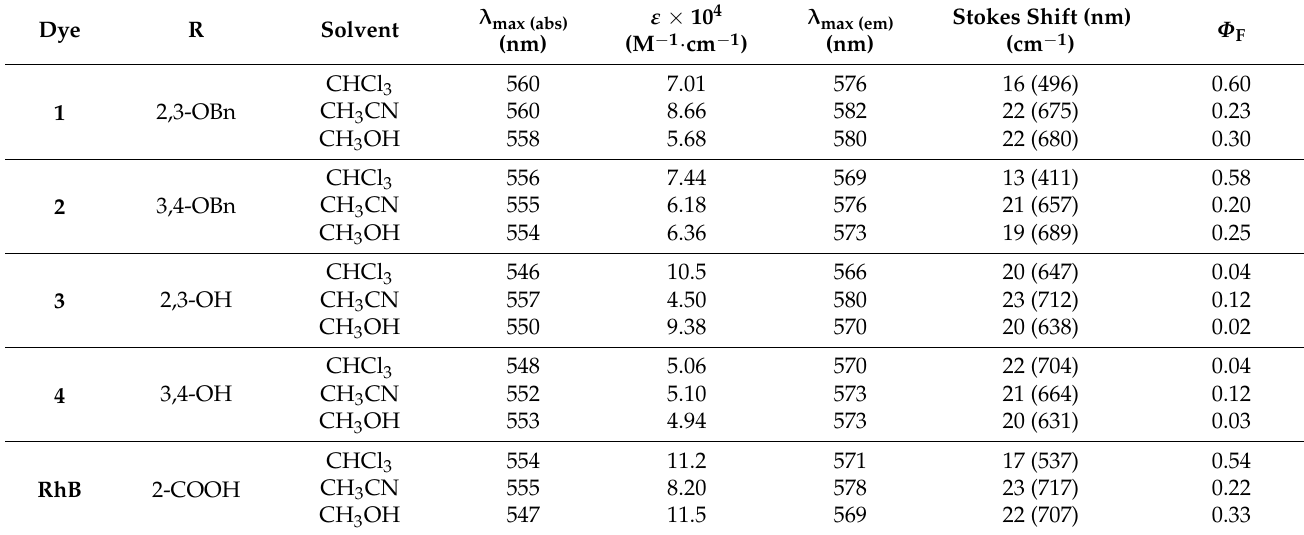
Table 1. Photophysical properties ( λ max abs , λ max em , ε , Stokes shift, and Φ F ) of rosamines 1 – 4 and RhB in chloroform, acetonitrile, and methanol at 25 ◦